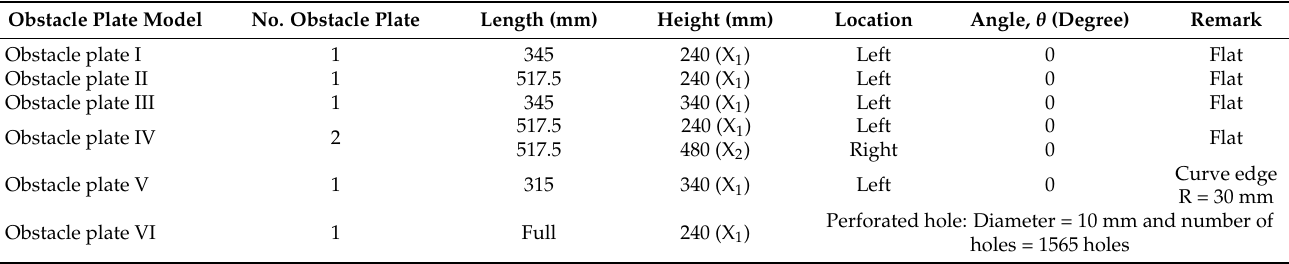
Figure 4. The geometries of the obstacle plate models: ( a ) Obstacle plate I and III models; ( b ) Obstacle plate II and IV models; ( c ) Obstacle plate V model; ( d ) Obstacle plate VI model; ( e ) The height of obstacle plates installation. Table 2. The dimensions of the obstacle plate